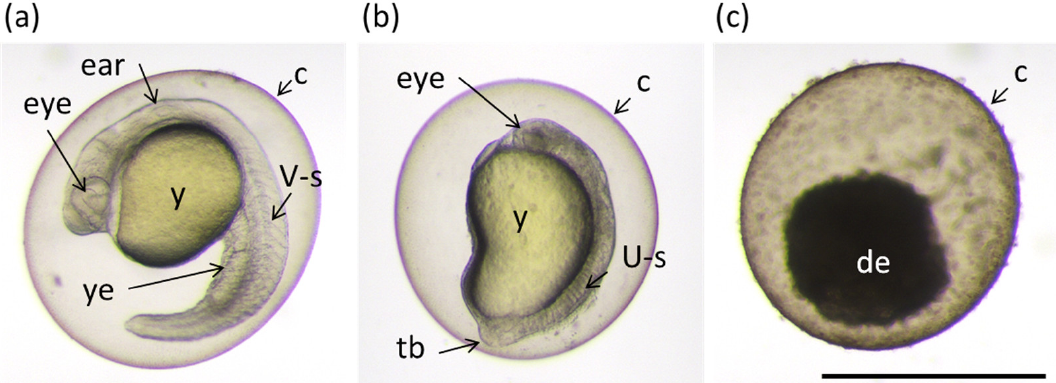
Figure 1. Examples of different phenotypes of zebrafish embryos at 24 h post fertilization (hpf) found in the bioassay described in the Section 2.6 “Toxicity”. ( a ) Normally developed embryo; ( b ) embryo with underdeveloped eye, brain and impaired extensions of yolk sack and tail; and ( c ) dead embryo. Ear; eye; y: yolk; ye: yolk extension; V-s: v-shaped somite; U-s: abnormally-shaped somite; tb: tail bud; and de: decomposing embryo. Scale bar equals 1 mm.